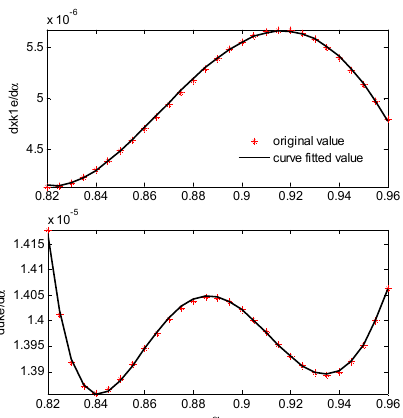
Figure 12. Modified H ∞ LPV controller.